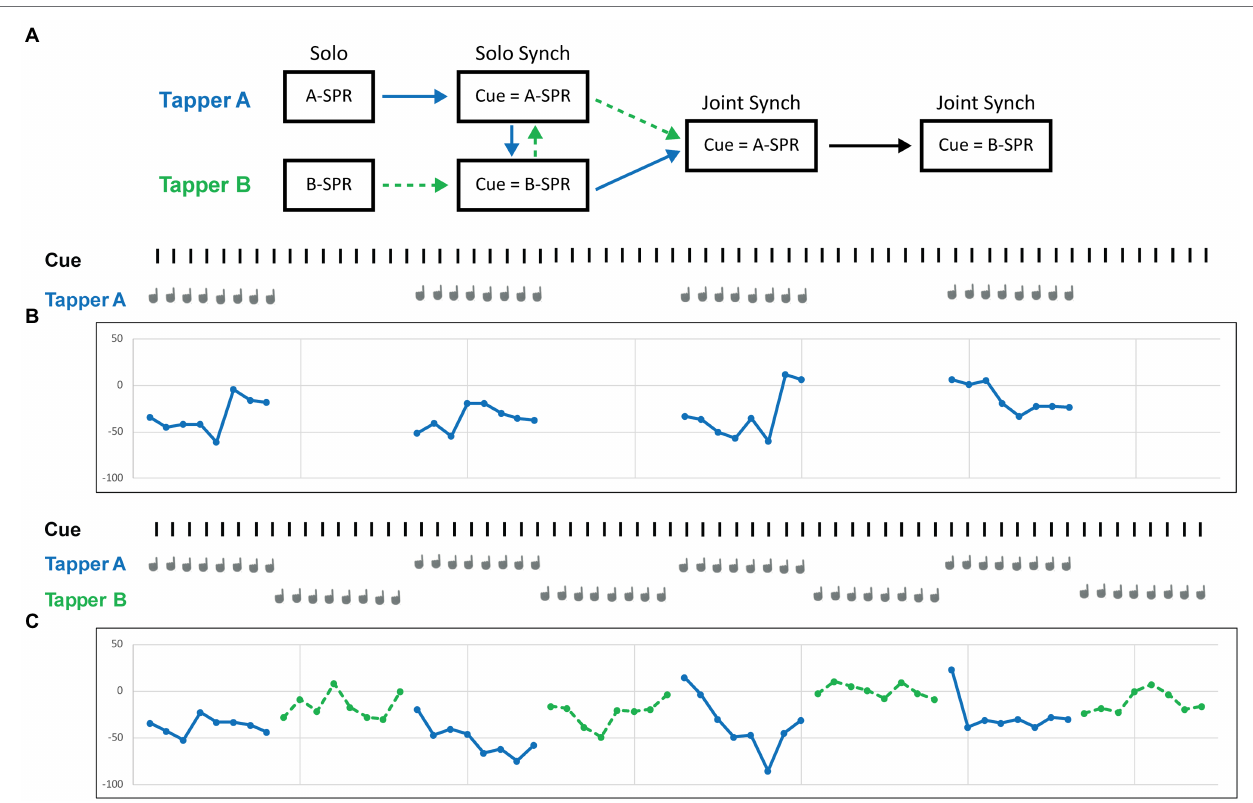
FIGURE 1 | Schematic representation of the experimental procedure. (A) Each partner completes the Solo SPR task, followed by the Solo Synchronization task first with the auditory cue set to their own SPR and then with the auditory cue set to their partner’s SPR. The two partners then complete the Joint (Turn-taking) Synchronization task first with the auditory cue set to one partner’s SPR and then to the other partner’s SPR. (B) Sample trial from one participant (Tapper A) in the Solo synchronization task with the auditory cue set to Tapper A’s SPR (545 ms ITI). (C) Sample trial from two participants in the Joint synchronization task with the auditory cue set to Tapper A’s SPR (545 ms